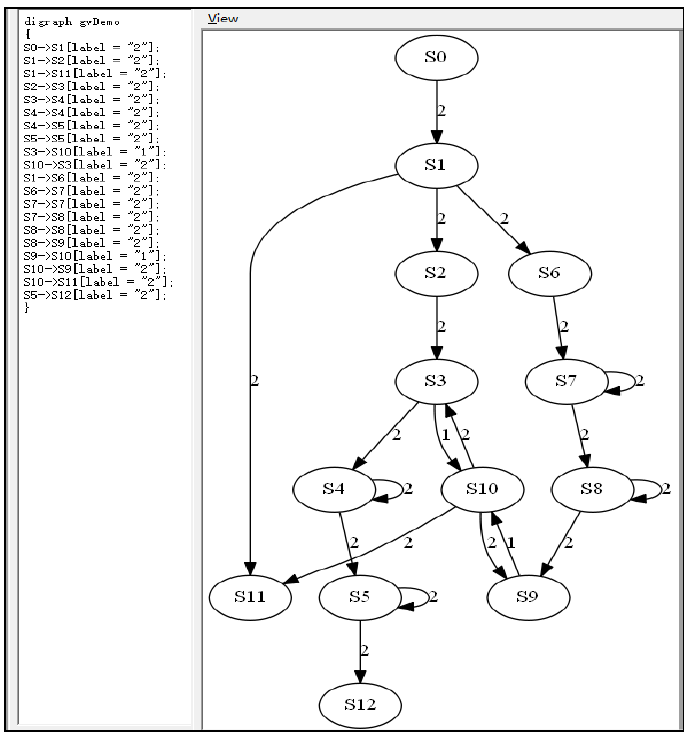
Figure 7. Service invocation diagram of client-side information reception module.